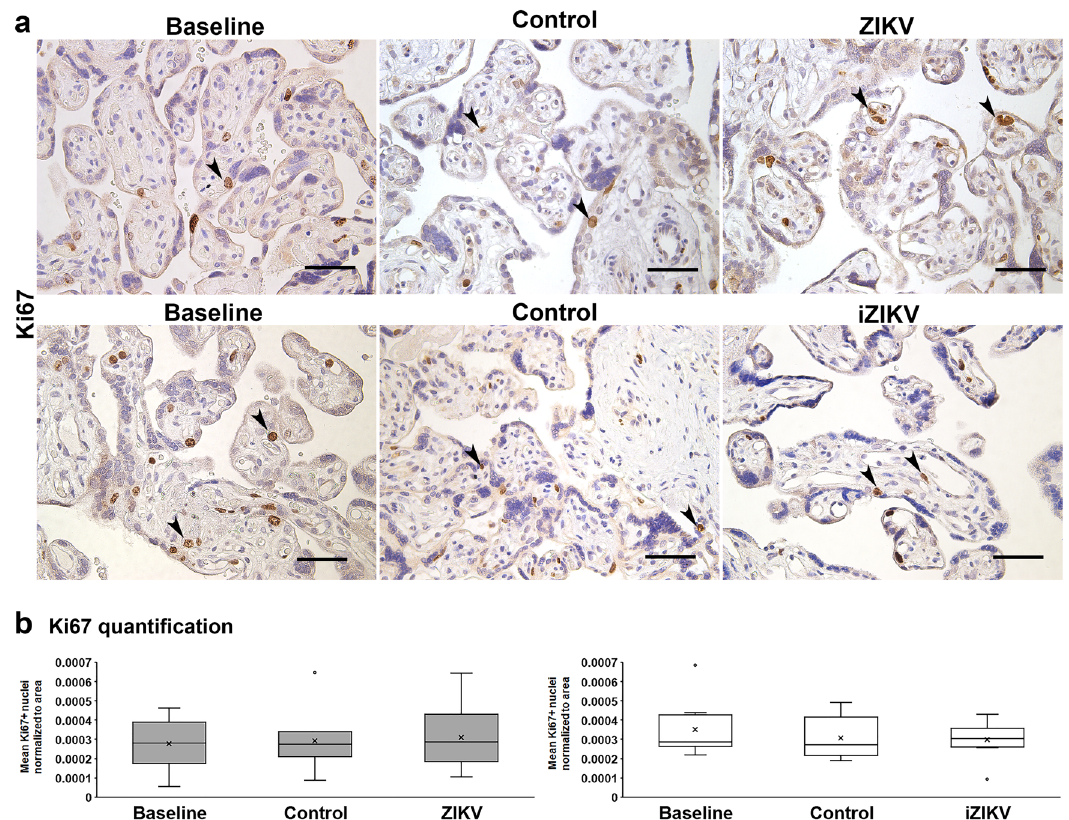
Fig. 7 Cell division unaltered in perfused cotyledons. a Representative of Ki67 staining with DAB and hematoxylin in Baseline, Control, and virus exposed samples. Scale bars = 50 µ m. Ki67 positive cells (arrowheads) appear as brown nuclei vs . blue nuclei counterstained with hematoxylin. b Quanti fi cation of Ki67 positive nuclei normalized to the area of tissue within each fi eld analyzed. The left graph represents n = 10 and right graph n = 9 samples per condition. Box-plots represent the median in the centerline, upper and lower quartiles at top and bottom of box, min/max points as whiskers, outliers as dot, and the mean with